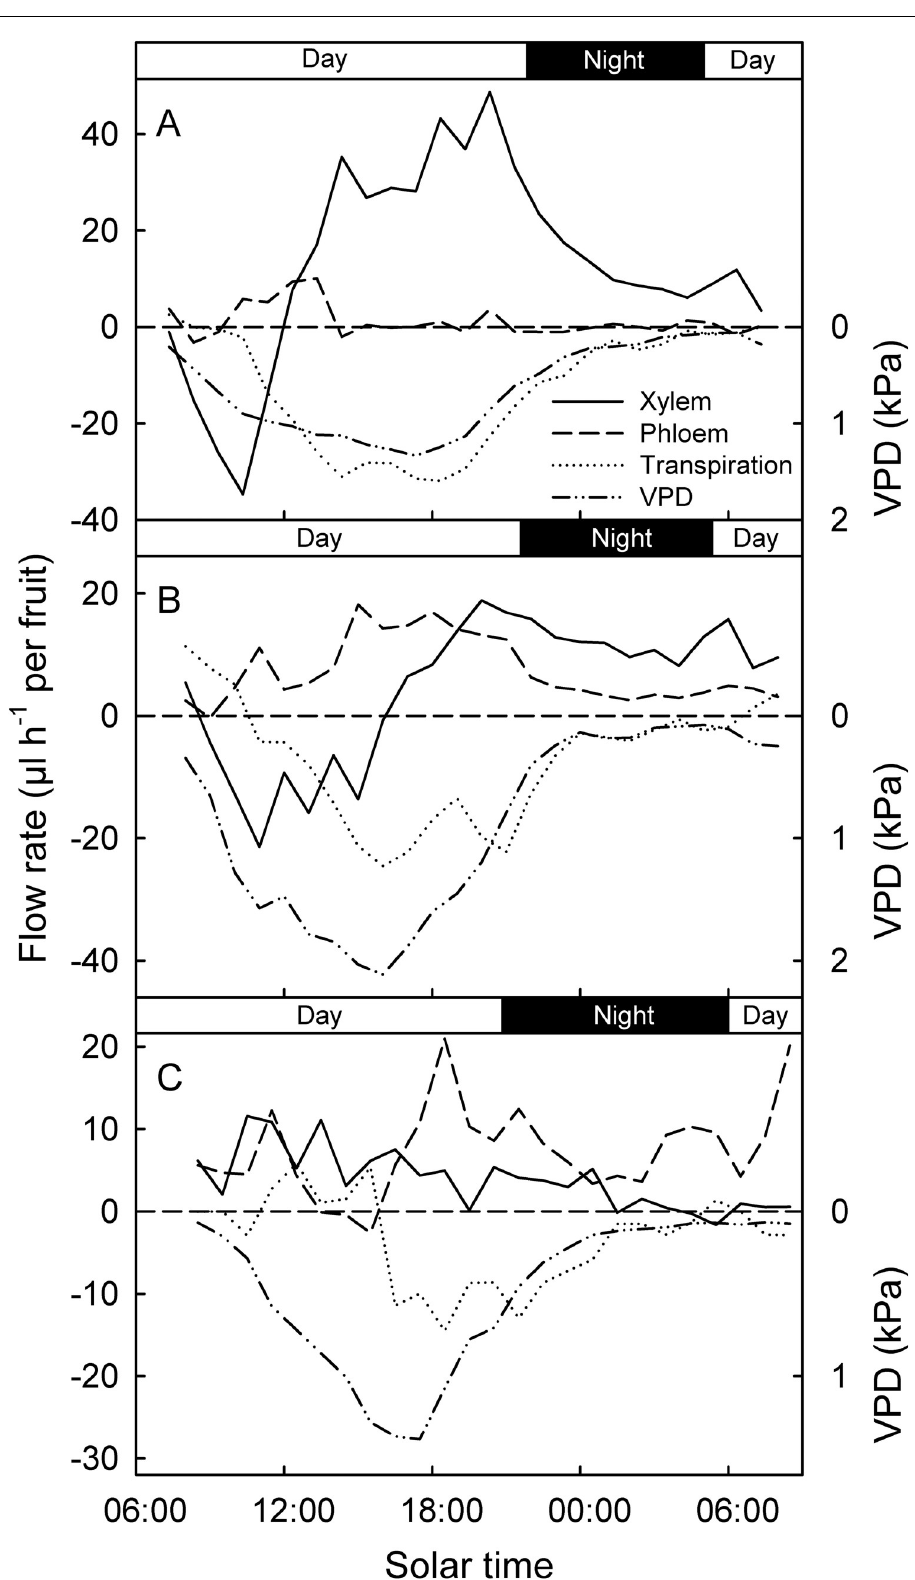
Fig 3. Representativediurnaltimecoursesof xylem,phloemandtranspirationflowratesindevelopingEuropeanplumfruit (A:StageII, 76daysafterfullbloom(DAFB),B:EarlystageIII,104DAFB,C:LatestageIII,132DAFB).Thepatternofchange inwatervaporpressuredeficit(VPD)isgivenforcomparison.Xylem,phloemandtranspirationflowswerecalculatedfrom netflowsdeterminedforun-treatedcontrolfruit,steam-girdledfruitanddetachedfruit.FordetailsseeMaterialsandMethods. https://doi.org/10.1371/journal.pone.0252085.g003 PLOS ONE | https://doi.org/10.1371/journal.pone.0252085 May 20,